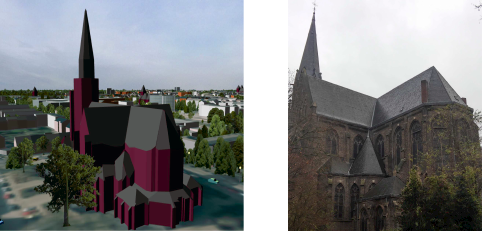
Figure 20: Johannes church in a city model context and in reality